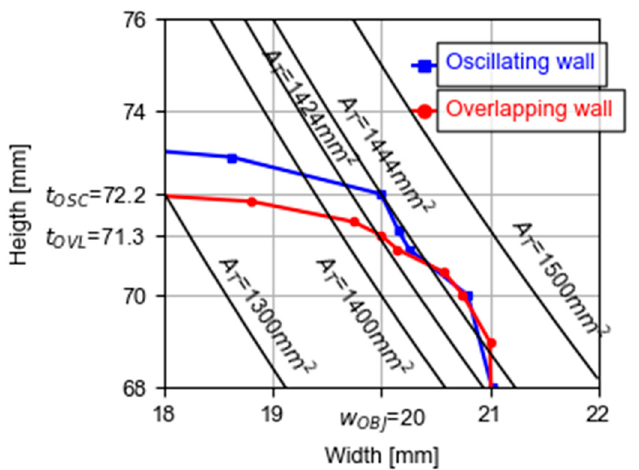
Figure 16. Calculation of the effective cross-sectional area of the wall manufactured according to the effective height and width in the different manufacturing strategies .